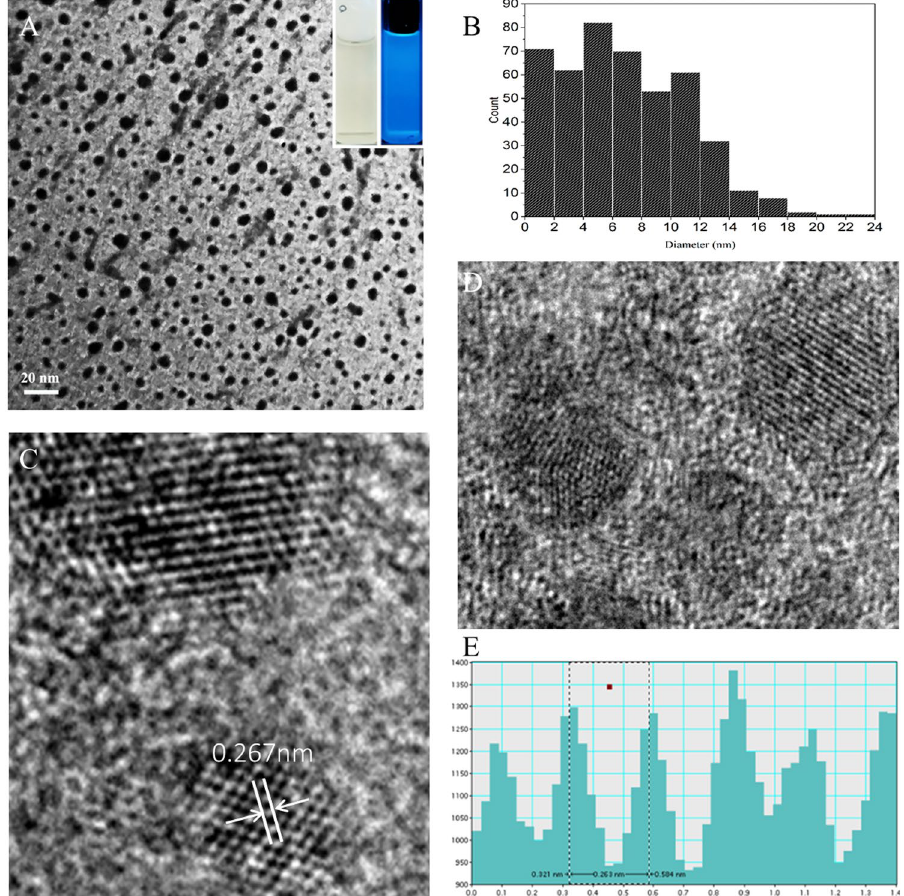
Figure 2. ( A ) Transmission electron microscopy (TEM) image of egg yolk oil carbon quantum dots (EYO CDs). (magnification 145,000x), the accelerating voltage was 100 kV. ( B ) Histograms of particle size distribution of EYO CDs. (magnification 880,000x), the accelerating voltage was 200 kV. ( C and D ) High-resolution TEM (HRTEM) images of individual EYO CDs. ( E ) The line profiles of the corresponding HRTEM images of EYO CDs. The lattice fringe (d = 0.267 nm) induced from the inplane diffraction of